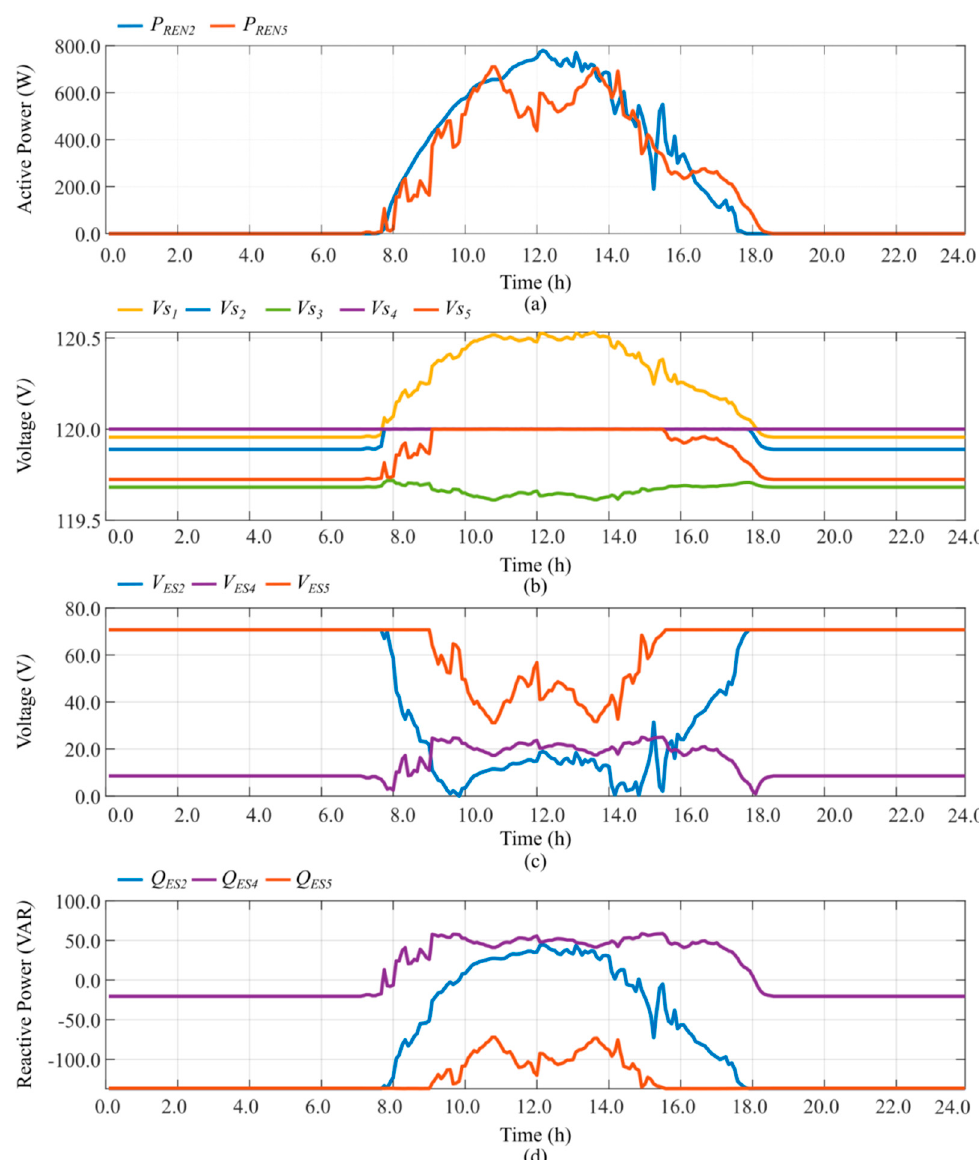
Figure 13. Quasi-stationary simulation model with real active power profiles. ( a ) Active power delivered by RES, ( b ) Node voltages, ( c ) ESs voltages, and ( d ) ESs reactive power.